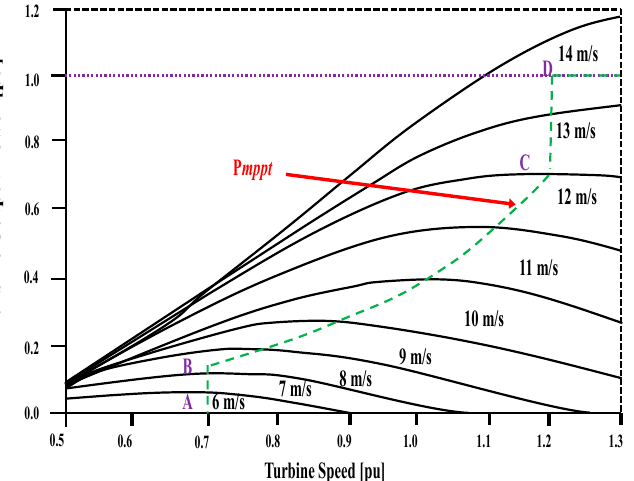
Figure 6. Characteristics of a wind turbine with maximum power point tracking (MPPT) for a doubly fed induction generator (DFIG).